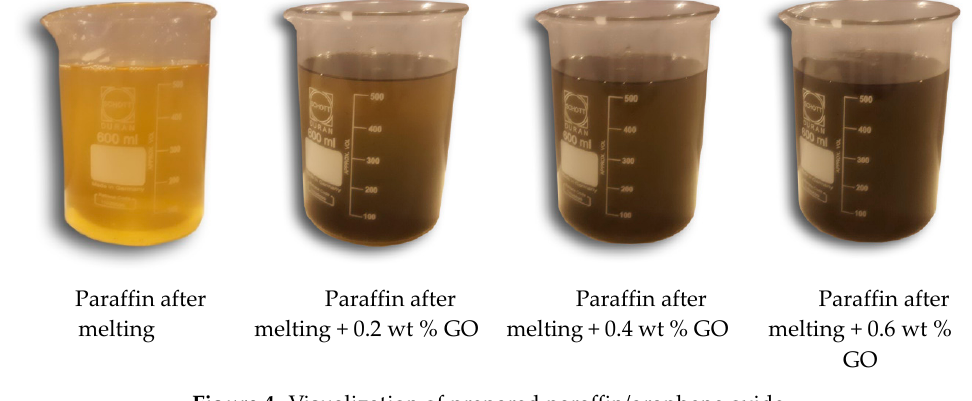
Figure 4. Visualization of prepared paraffin/graphene oxide.